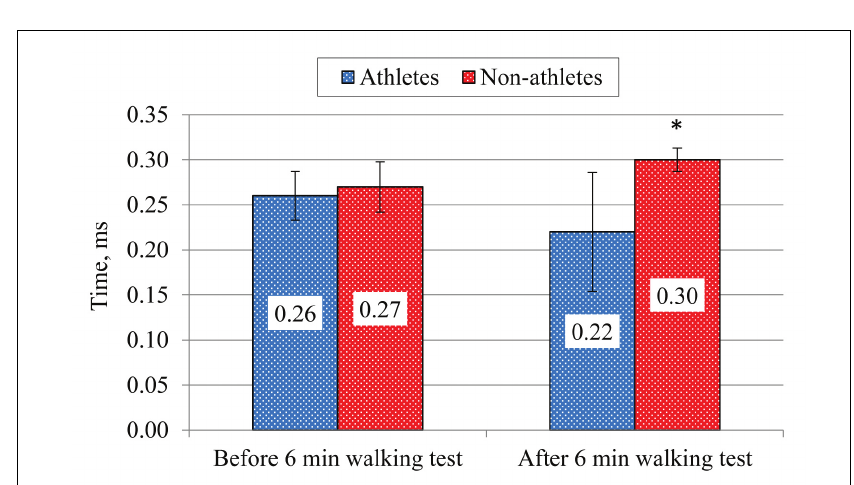
Note. * – p < 0.05, Mann–Whitney U